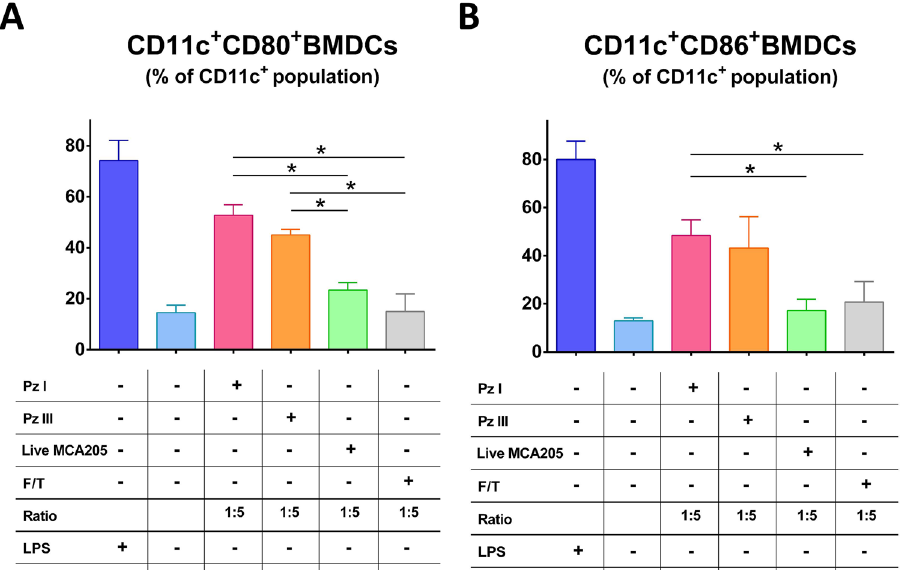
Figure 5. Cancer cells killed by pzI-PDT or pz III-PDT induce activation and maturation of BMDCs in vitro. BMDCs were cocultured with dying MCA205 cells treated either with pz I-PDT or pz III-PDT, or were cocultured with viable MCA205 cells at 1:5 ratio. Percentages of CD11c + CD80 + ( A ) and CD11c + CD86 + ( B ) BMDCs cells shown as mean values ± SEM of three independent experiments. BMDCs stimulated with LPS served as positive control while fibrosarcoma MCA205 cells subjected to the several cycles of freeze–thaw (F/T) were used as a negative control (at 1:5 ratio). Besides, BMDCs left untreated were used as a negative control. Statistical significance was calculated by a multiple t-test using Sidak-Bonferroni method, * p < 0.05.